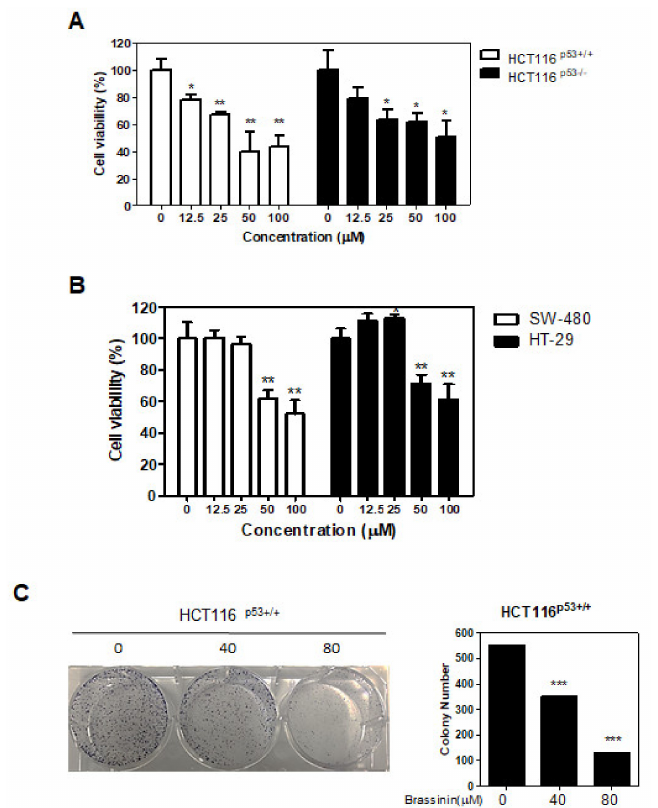
Figure 4. The cytotoxic effects of Brassinin in colon cancer cells. ( A , B ) Cytotoxicity of Brassinin in HCT116 p53+/+ , HCT116 p53 − / − , SW-480, and HT-29 cells in a dose-dependent manner by CCk8 assay. ( C ) Photo and bar graph for colony formation of Brassinin in HCT116 p53+/+ . The colonies were stained with crystal violet. * p < 0.05, ** p < 0.01, *** p < 0.001 vs. untreated control. Values of Western blotting images represent relative level of protein expression/ β